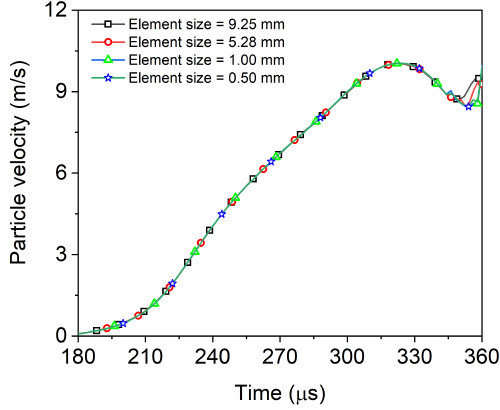
Figure 2. Comparison of particle velocities for FE models with different mesh sizes (0.5 to 9.25 mm) demonstrating that the mesh size of 1 mm is small enough to meet the convergence of